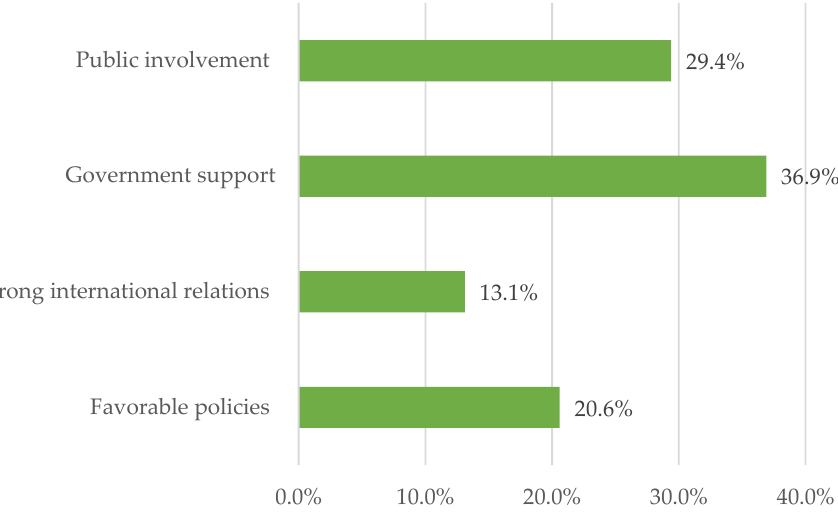
Figure 3. Strategies for improved disaster resiliency. Source: Authors’ own work (2022).